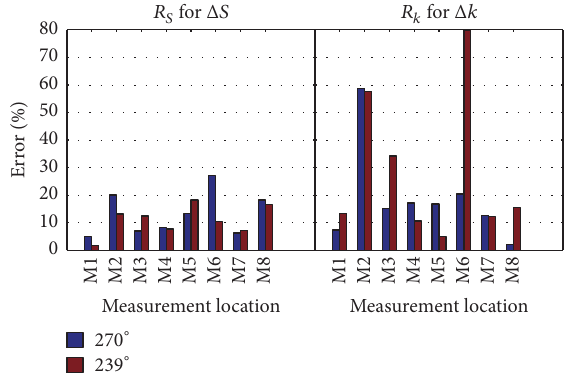
Figure 13: Simulation errors 𝑅 𝑆 for speedup and 𝑅 𝑘 for TKE increase at different measurement heights. The errors ( 𝑅 𝑆 and 𝑅 𝑘 ) are averaged over all the locations (masts) having the same